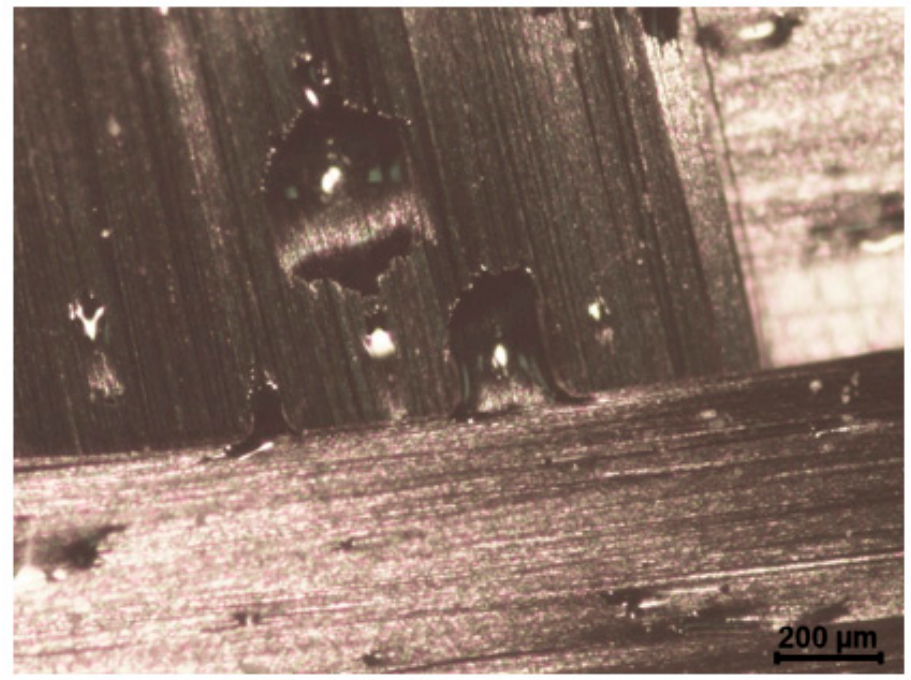
Figure 9. Micro observations of different types of preform.